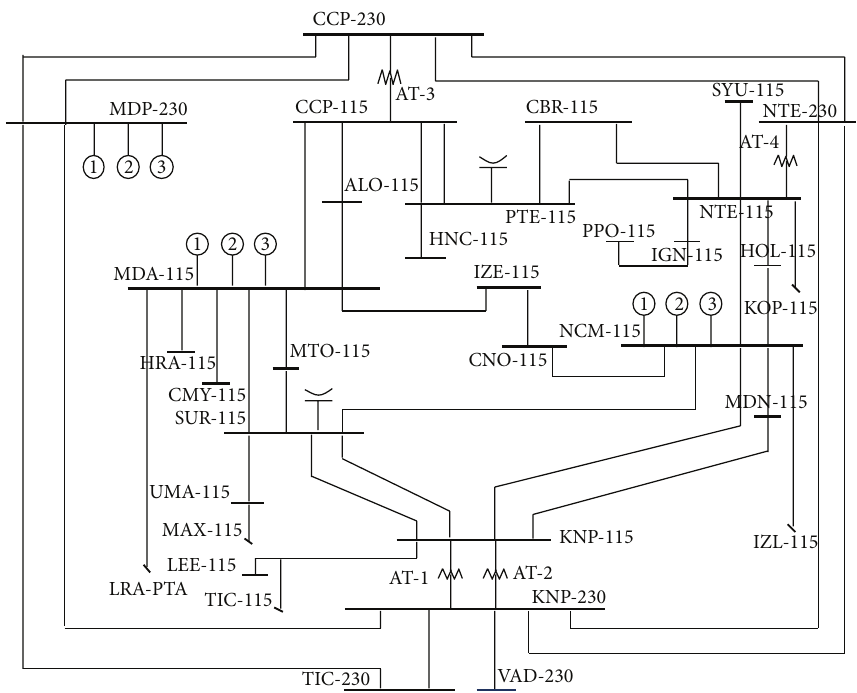
Figure 10: Electric power network for the urban area of the city of Merida, Yucatan, Mexico.